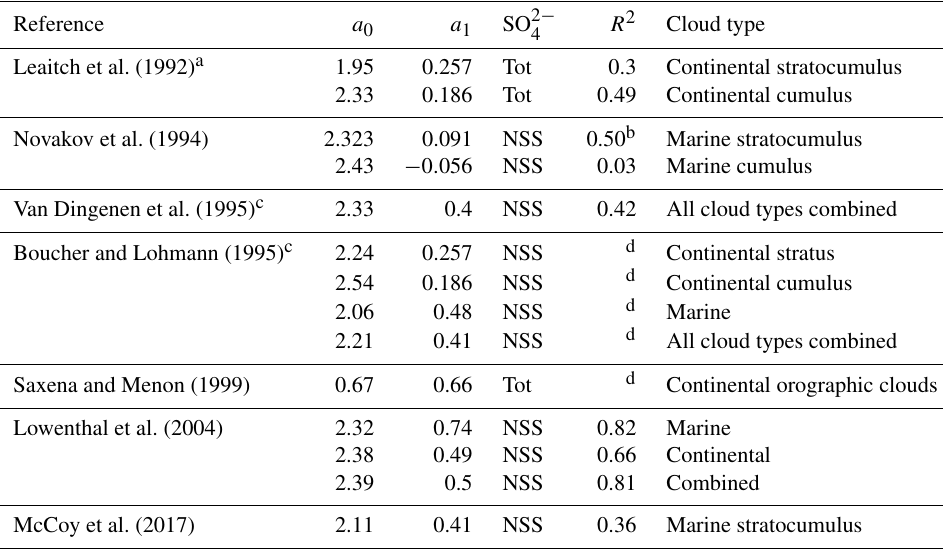
(total or non-sea-salt). The coefficients correspond to a 4